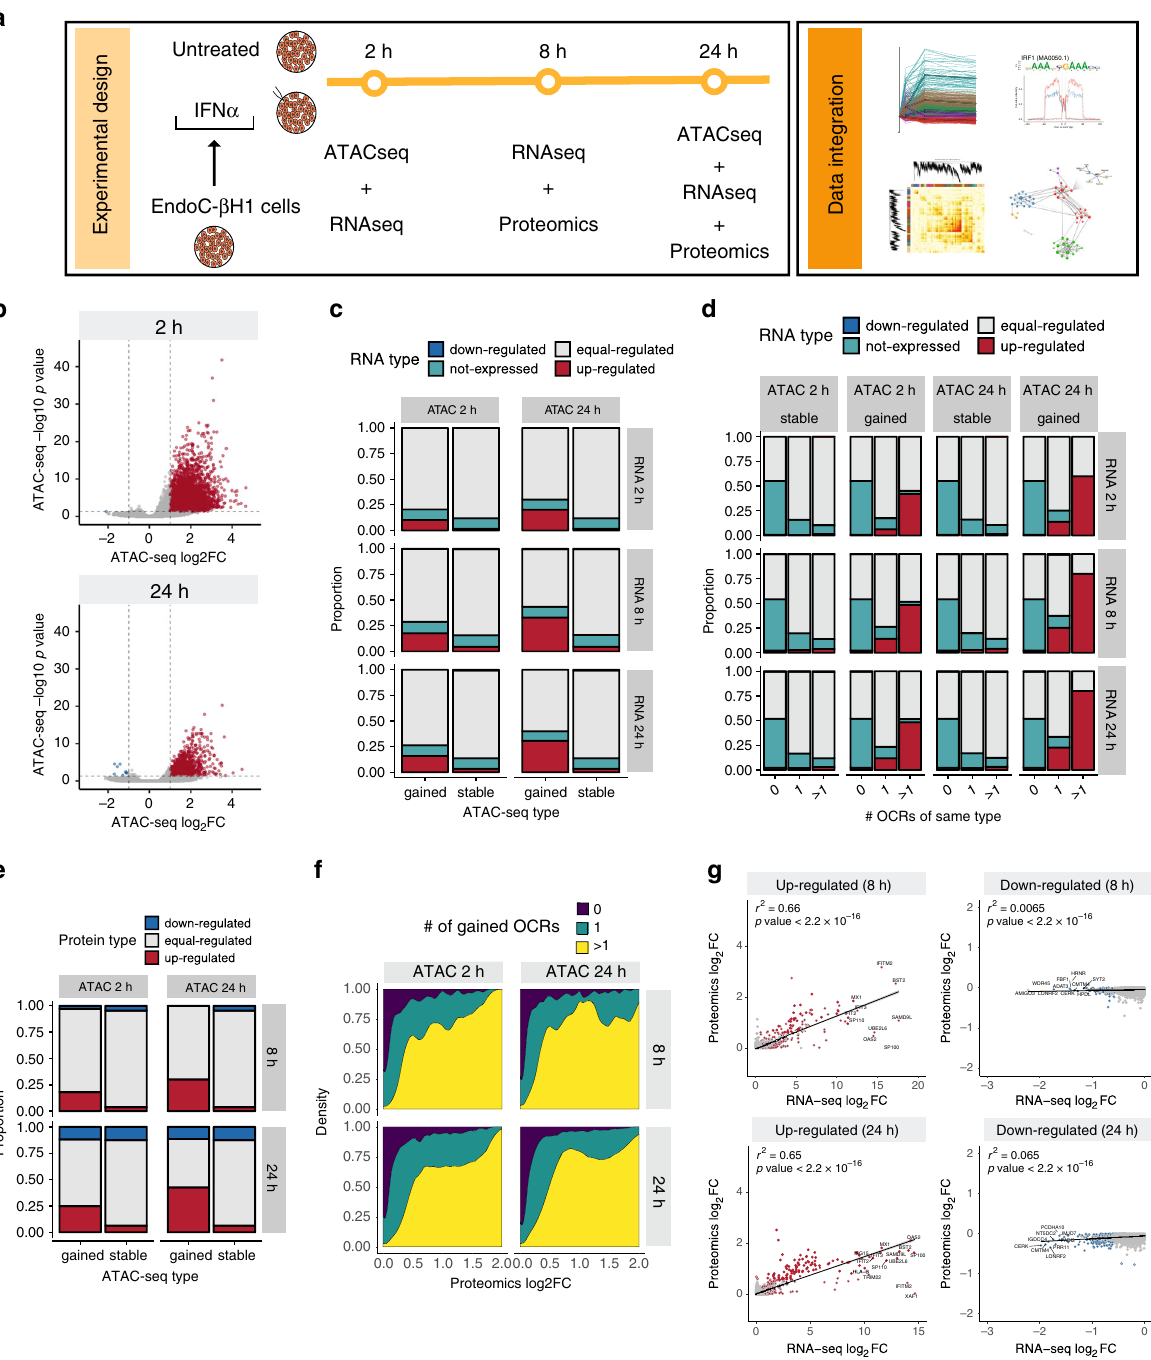
Fig. 1 Exposure of EndoC- β H1 cells to interferon- α promotes changes in chromatin accessibility, which are correlated with gene transcription and translation. a EndoC- β H1 cells were exposed or not to IFN α (2000 U/ml) for the indicated time points and different high-throughput techniques were performed to study chromatin accessibility (ATAC-seq, n = 4), transcription (RNA-seq, n = 5) and translation (Proteomics, n = 4). b Volcano plot showing changes in chromatin accessibility measured by ATAC-seq. Open chromatin regions indicated as gained (red) or lost (blue) had an absolute log 2 fold- change (|log 2 FC|) > 1, and a false discovery rate (FDR) < 0.05. The regions that did not reach such threshold were considered “ stable ” (gray). c , d Frequency of upregulated, downregulated or stable transcripts in the vicinity (<20 kb transcription start site (TSS) distance) of one or multiple open chromatin regions (OCRs) as classi fi ed in b . e Frequency of differentially abundant proteins in the vicinity (<20 kb TSS distance) of gained or stable open chromatin regions. f Distribution of IFN α -induced changes in protein abundance among upregulated proteins based on the number of linked gained OCRs. g Correlation between RNA-seq and proteomics of EndoC- β H1 cells exposed to INF α . The x axis represents the mRNA log 2 FC. The most upregulated (log 2 FC > 0.58, FDR < 0.05) and downregulated (log 2 FC < − 0.58, FDR < 0.05) mRNAs are fi lled in red and blue, respectively. The y axis indicates the proteomics log 2 FC. The proteins most upregulated (log 2 FC > 0.58, FDR < 0.15) or downregulated (log 2 FC < − 0.58, FDR < 0.15) are represented by red and blue borders, respectively. mRNAs and proteins not meeting these criteria were considered equal-regulated (gray fi ll and border,